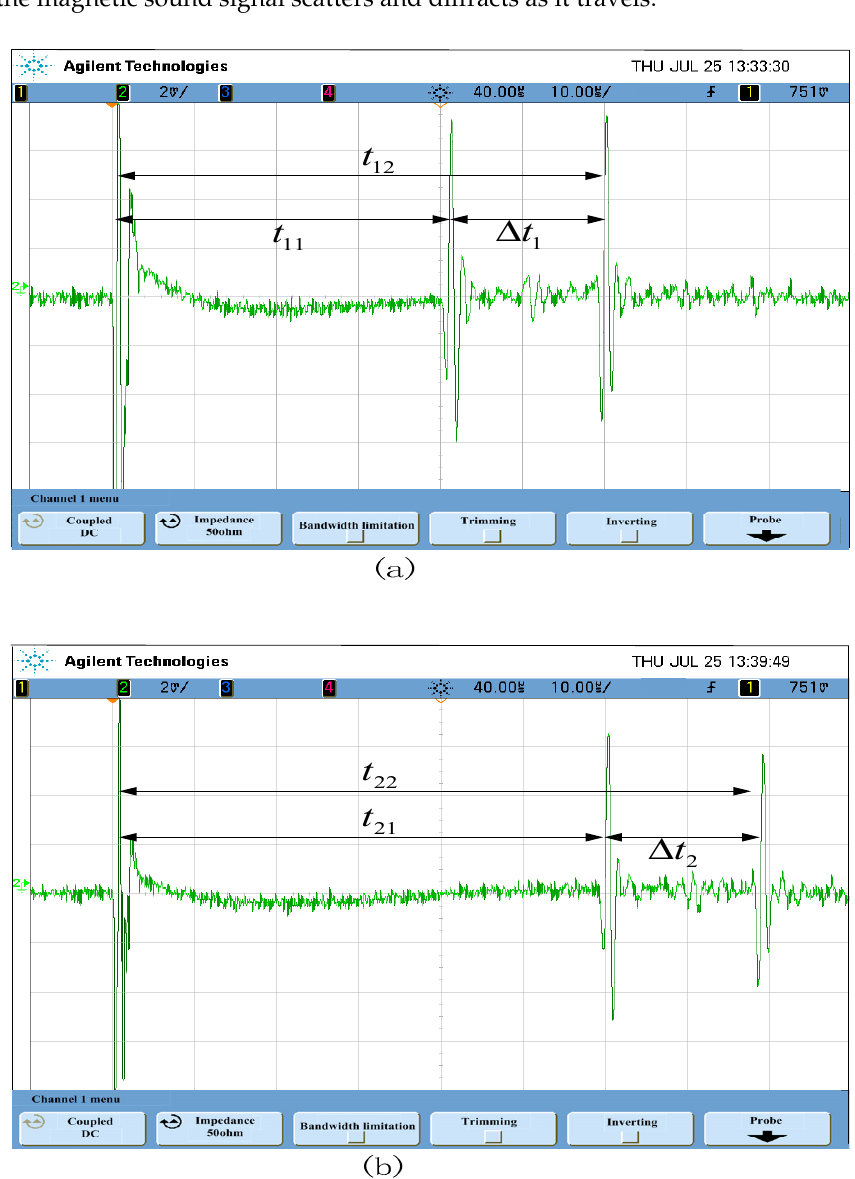
Figure 15. The magnetic sound signal collected from the experiment .